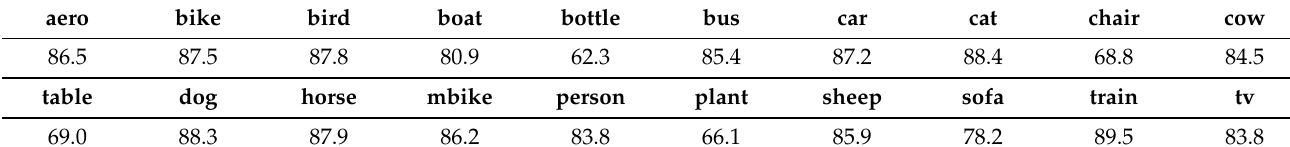
Table 6. ESDet-baseline Performance (mAP %) on the PASCAL VOC 2007 Test Set.